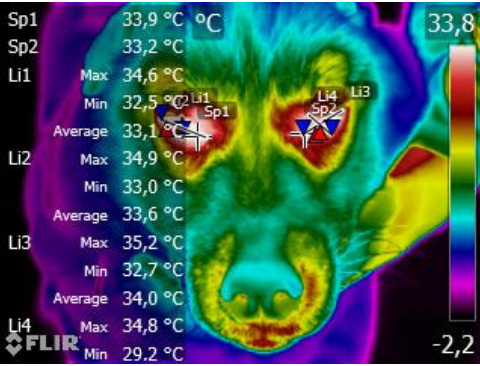
Figure 1. Five-and-a-half-year-old, female, Siberian Husky dog. Example of ocular measurement as the average value resulting from the three different values obtained on the hotspot centered on the medial canthus of the eye and on two perpendicular lines, drawn from the dorsal to the ventral margin of the eye and from the ocular medial canthus to the lateral one. The brighter colors (red, orange, and yellow) indicate warmer temperatures (more heat and infrared radiation emitted), while the purples and dark blue/black indicate cooler temperatures (less heat and infrared radiation emitted). Moreover, all commas inserted in the measurements within the figure are indicated ac- cording to the Italian style, therefore they must be understood as points to indicate decimals follow- ing the British style (e.g., “33,9” in Italian style has to be intended as “33.9” following the British style). Sp = Spot. Li = Line. Regarding the other ROIs, elliptical areas corresponding to the main body regions were identified within each image, as well as lines (major axis of the ellipse) and points within the areas: the final surface temperature was obtained from the average of the measurements obtained in areas, lines and points (Figure 2).